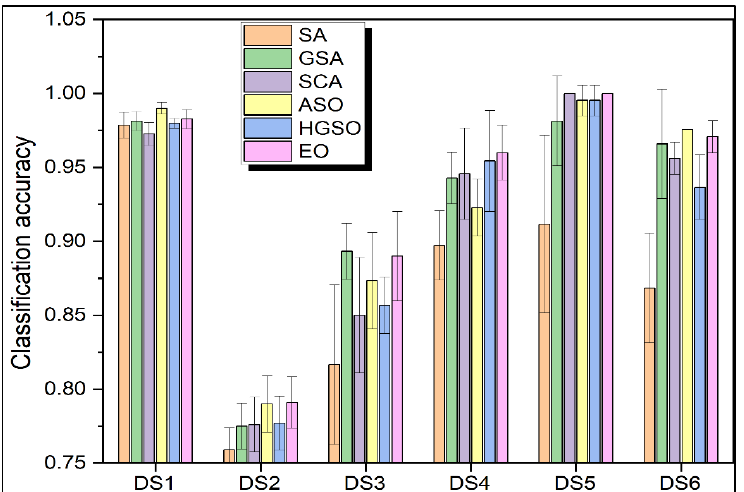
Figure 3. Average classification accuracy and standard deviation of all algorithms on all selected datasets.